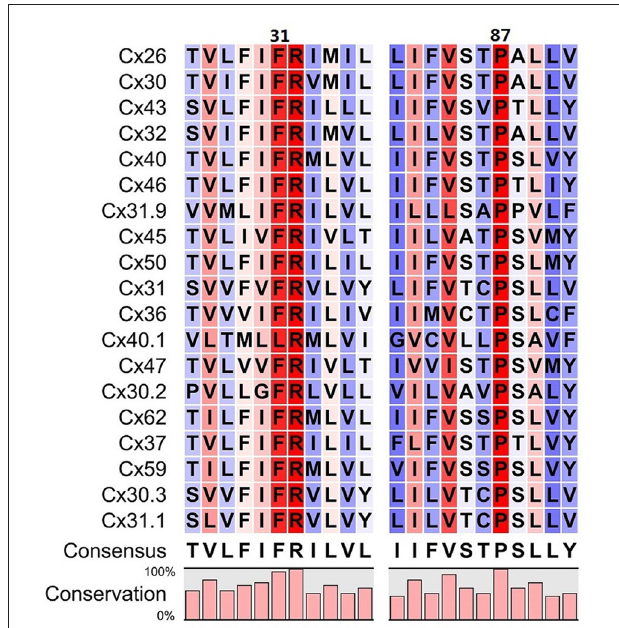
FIGURE 9 | Sequence alignment around residues 31 and 87 of the 19 human connexins that are known to be translated into proteins. Colors refer to the percentage of consensus, from blue (30%) to red (100%), numbering refers to the amino acid sequence of Cx26. Amino acids in positions 86 always have a small side chain (T, A, C, V, S), with the only exception of Cx40.1 (L). In this connexin, the phenylalanine in position 31 is replaced by a leucine, whose side chain is smaller, assuring that the overall steric hindrance of the two opposed amino acids is conserved along the family.